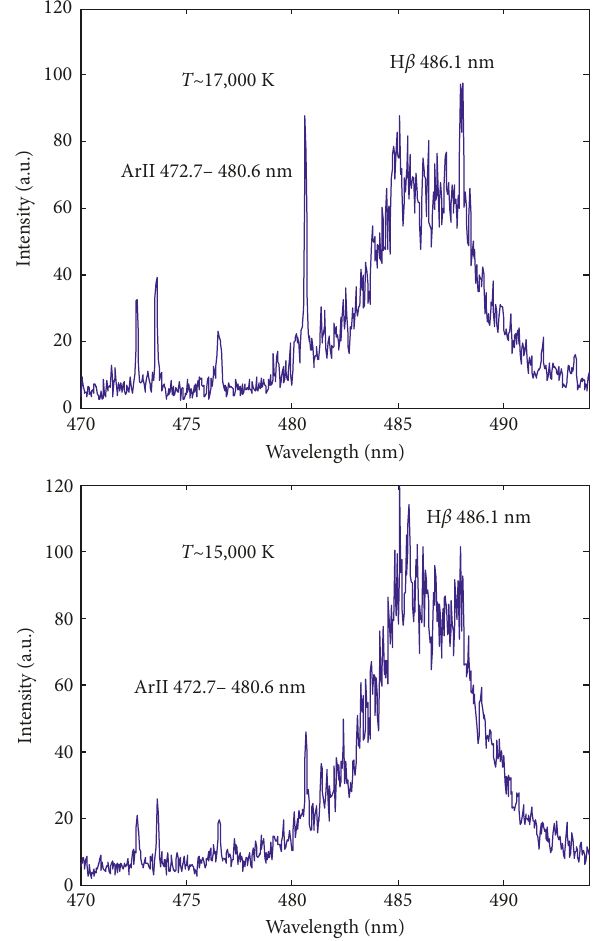
Figure 5: Typical emission spectra with the central wave- length near H β line. The ratio of intensities of H β to ArII lines is apparently different when the temperature is 17,000K (a) and 15,000K